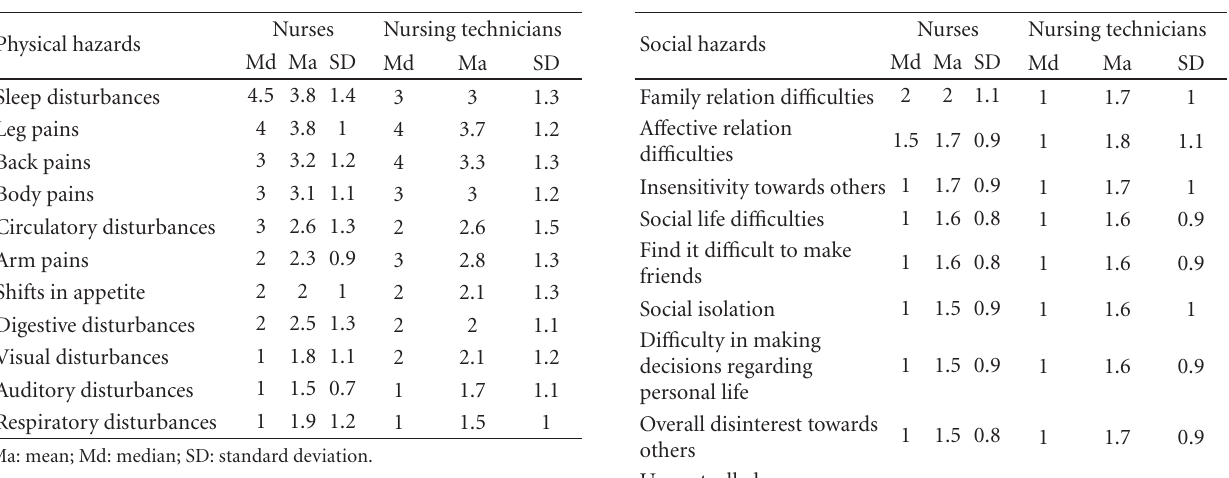
Table 2: Medians, means, and standard deviations of physical damage among nurses and nursing technicians, Bras´ılia, 2007.